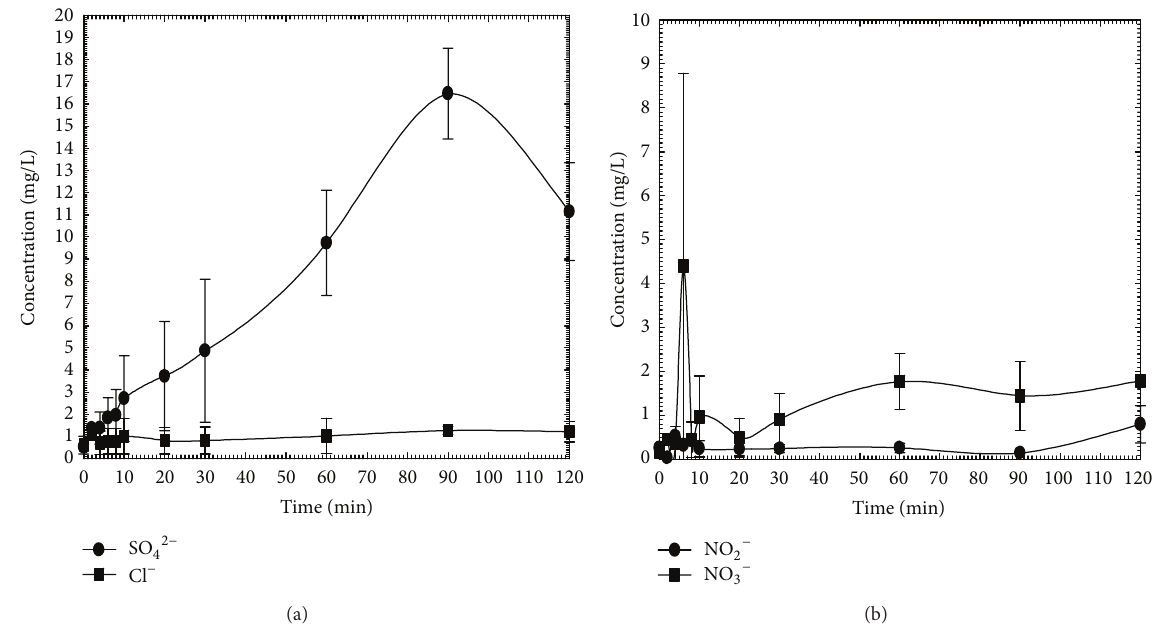
Figure 11: The product analysis by IC, (a) SO 42− and Cl − , and (b) NO 3− and NO 2− . The conditions were initial dye concentration of 50 mgL −1 , ZnO-coated amounts of 60 gm −2 , and light intensity of 2.1mWcm −2 at 120min.